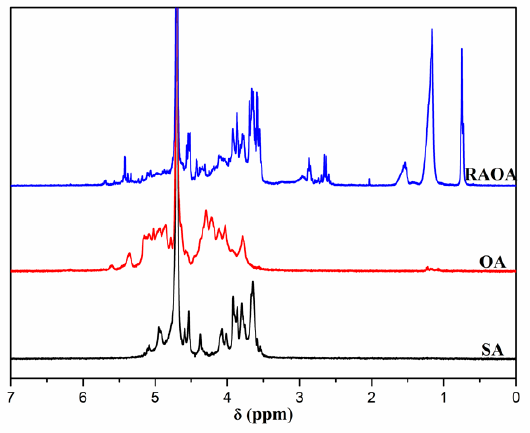
Figure 2. 1 H NMR spectra of SA, OA and RAOA.